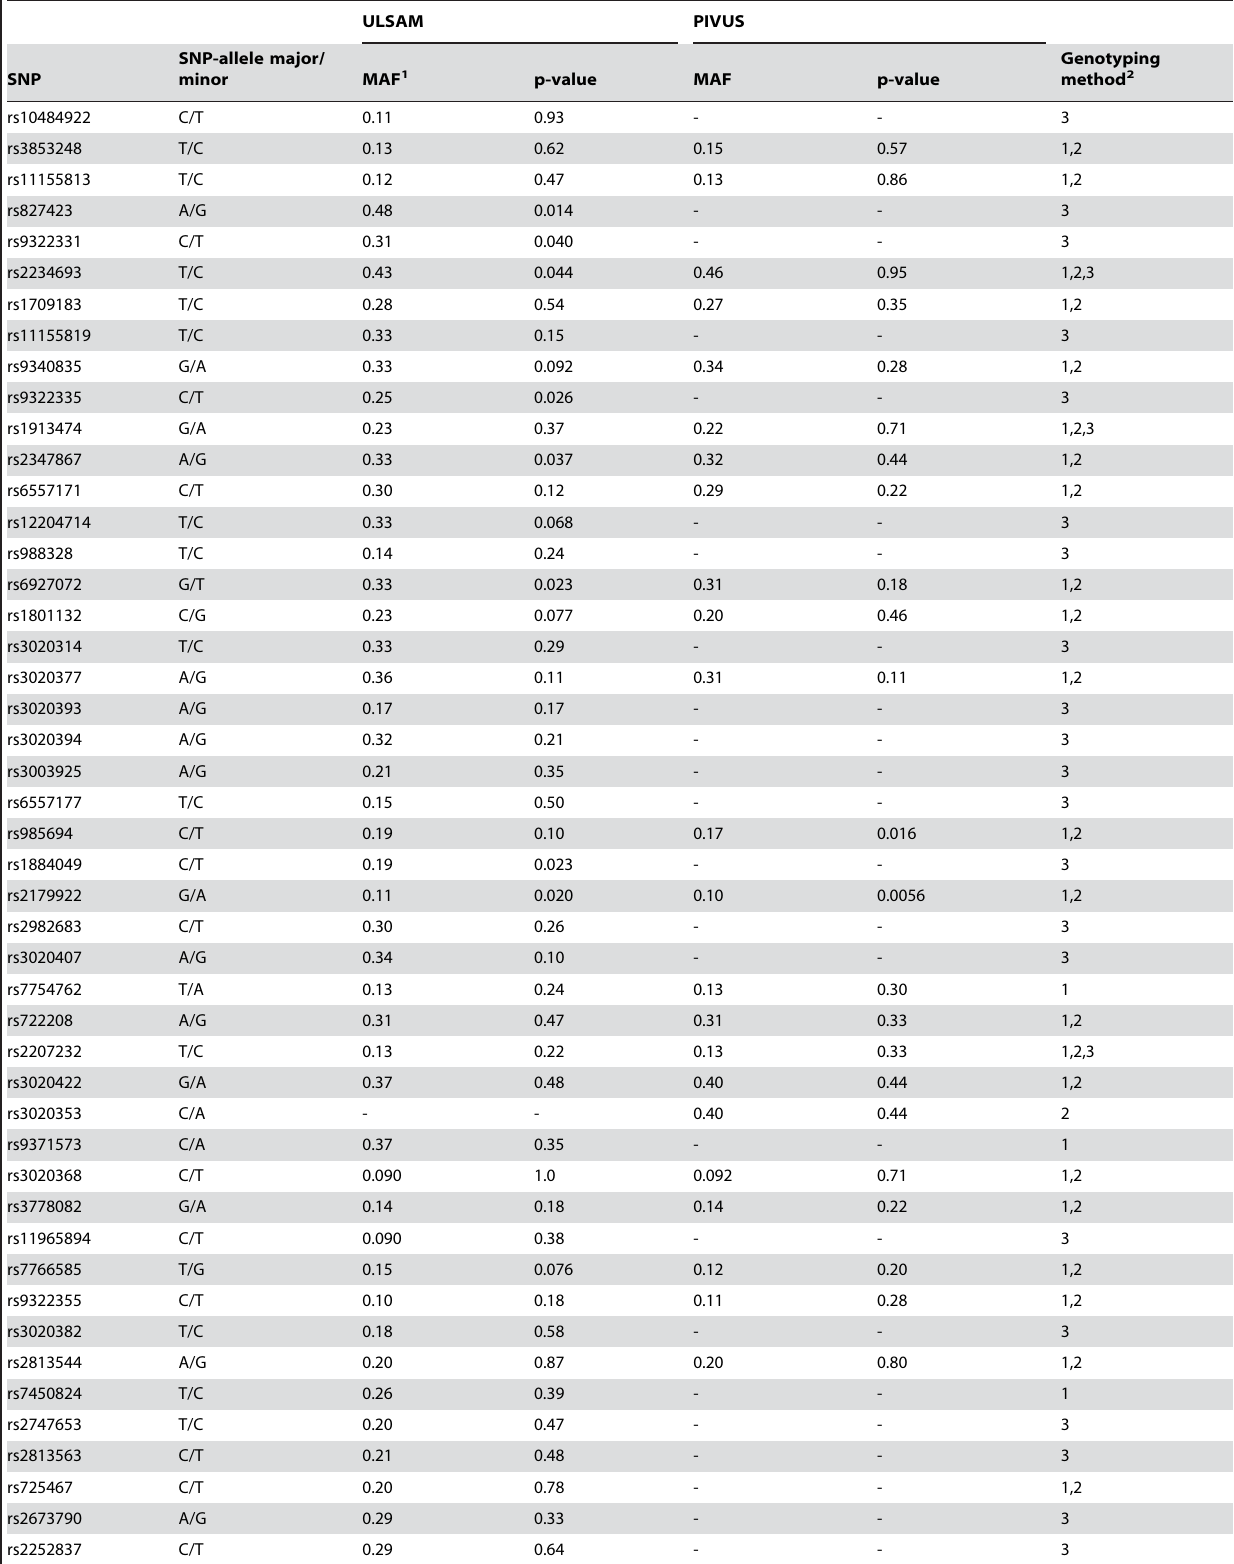
Table 2. SNPs genotyped in the estrogen receptor alpha